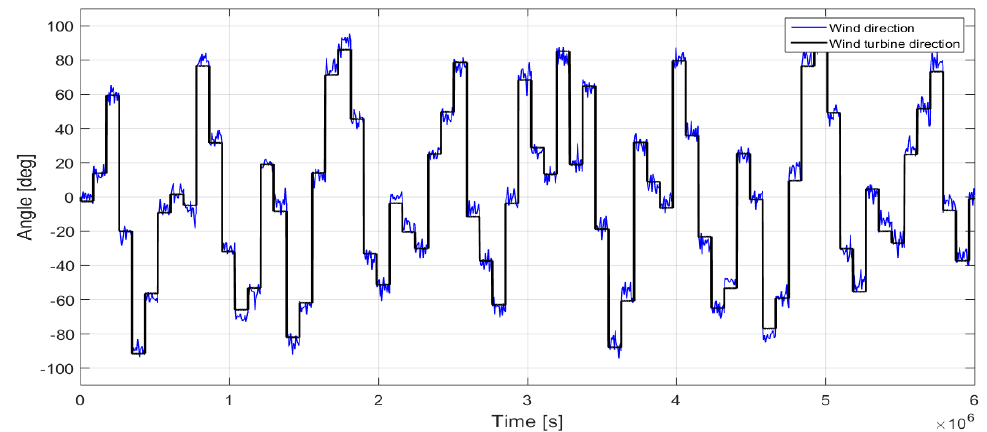
Figure 11. Wind direction tracking performed by the I regulator for the yaw control of a wind turbine.